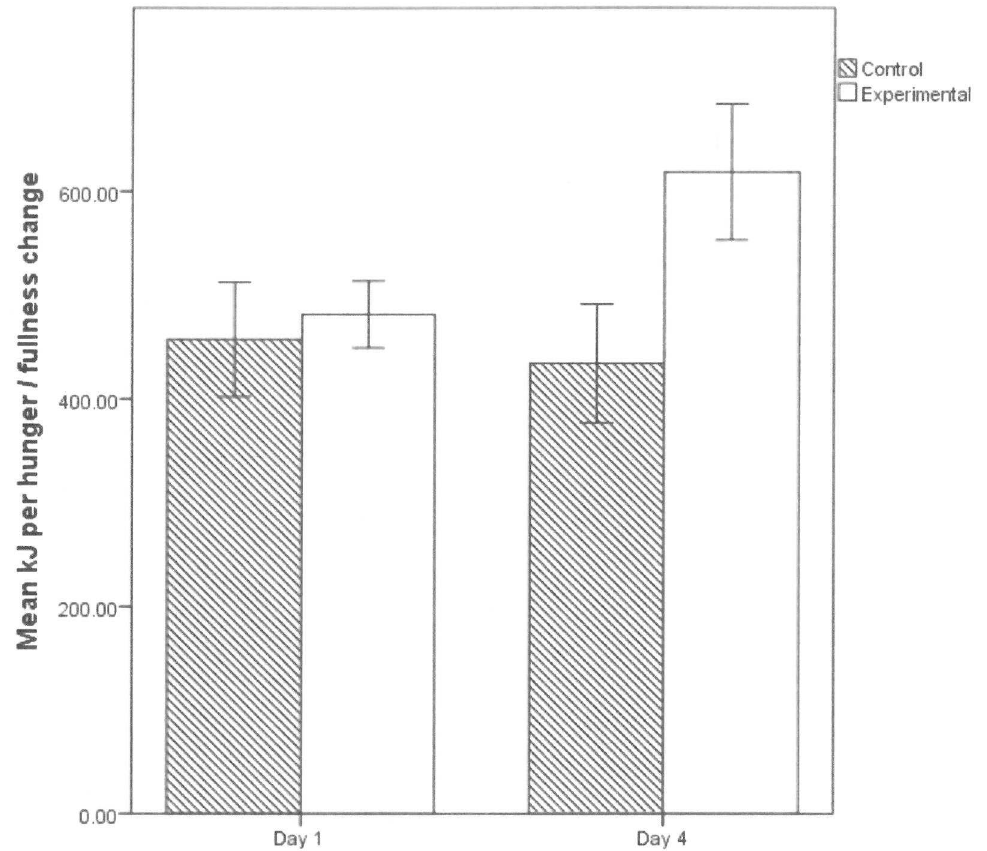
Fig 2. Interoception scores. Mean ( ± standard error) kilojoules(kJ) requiredto shift hungerand fullness ratings on days one and four for each